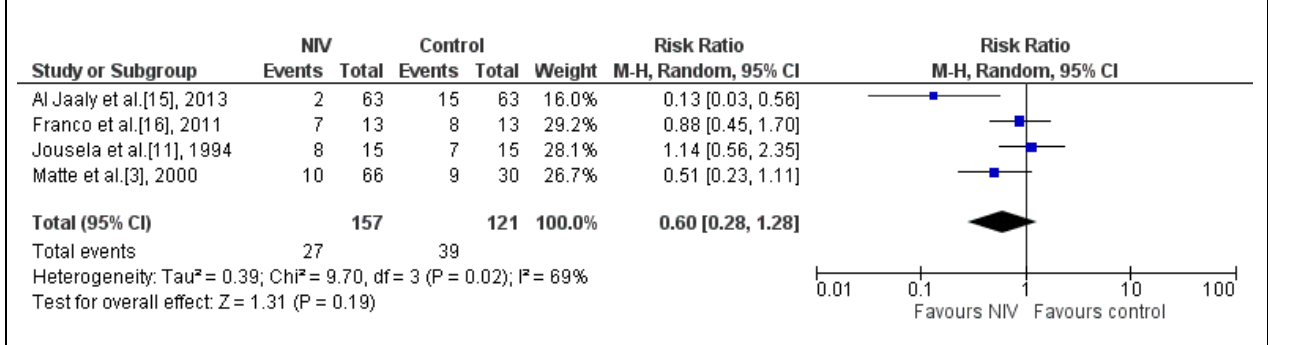
Fig. 2 – Analysis of the atelectasis regarding the studies that compared the prophylactic NIV to the control group. NIV=noninvasive